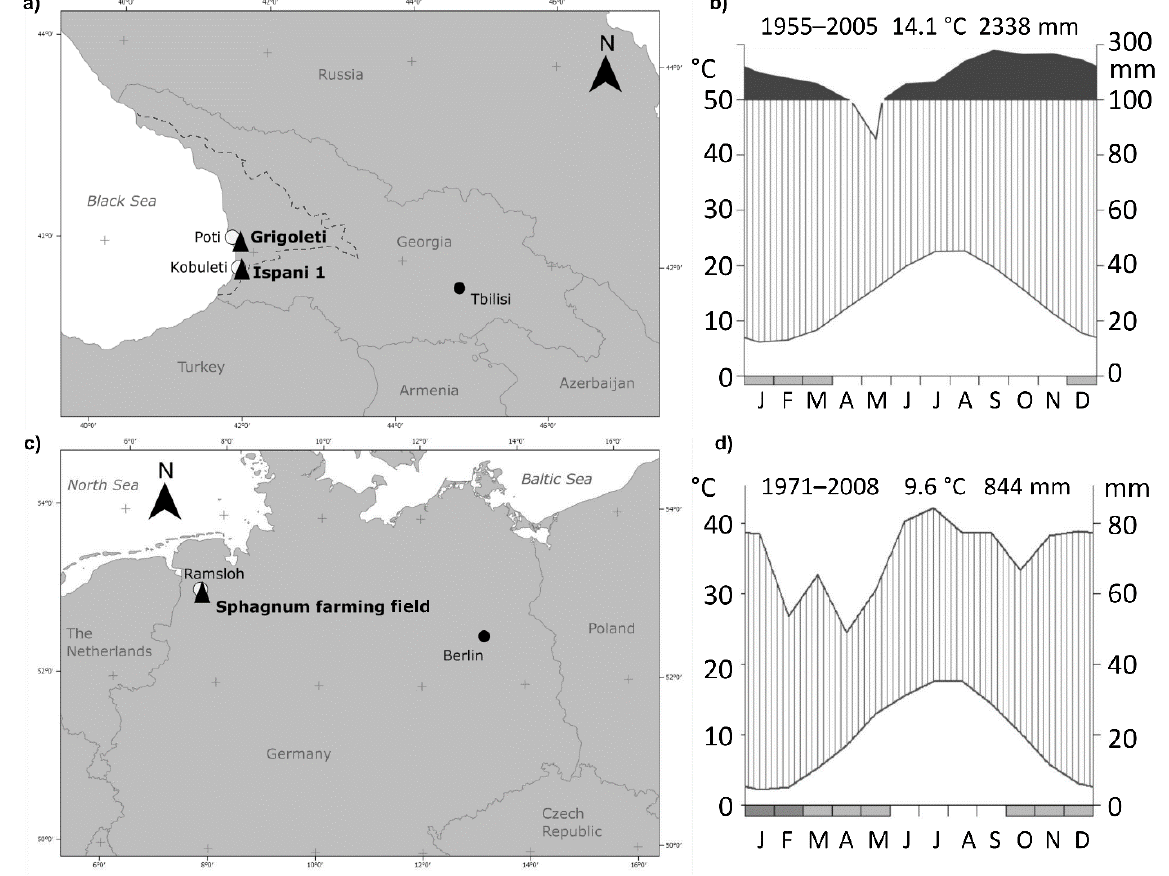
Figure 1. Locations of the study areas (▲) in Georgia (a) and north-west Germany (c) with nearby settlements (  ). The dark grey dashed line in (a) indicates the extent of the Kolkheti Lowlands. The climate graphs (Walter & Lieth 1967) for Kobuleti (b, after Krebs et al. 2016) and Ramsloh (d, after Gaudig et al . 2017) show mean monthly temperature (°C) on the left-hand axis and precipitation (mm per calendar month) on the right-hand axis. The numbers at the top of the diagram show the period of data recording followed by mean annual temperature and mean annual precipitation for that period. The bar at the bottom of the diagram is shaded dark grey for months with frost, and light grey for months with possible frost. Note the break in scale of the precipitation axis in